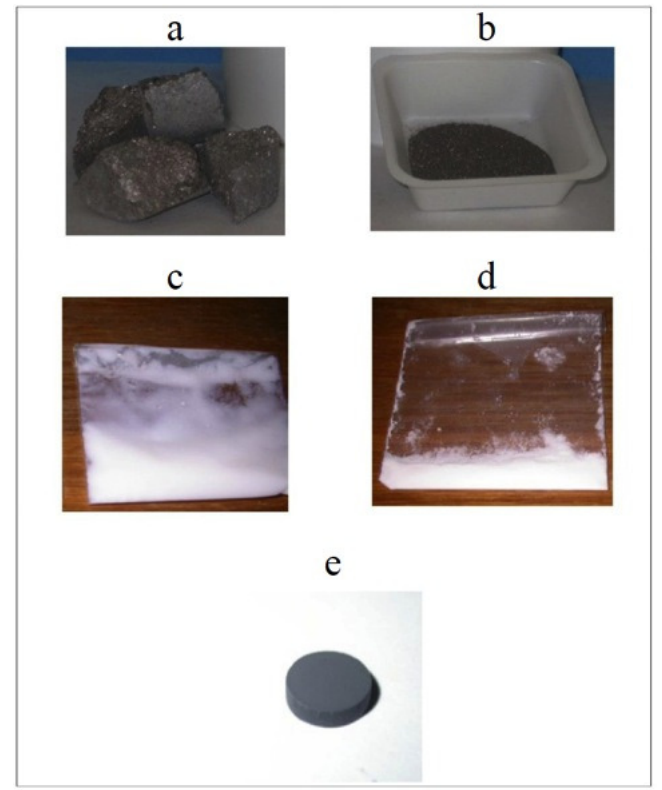
Figure 1. A view of the starting and processed materials. Intermetallic alloy: ( a ) after cast; ( b ) after 15 min HEBM processing. Pyrogenic silica; ( c ) as received; ( d ) after HEBM processing; ( e ) Consolidated composite